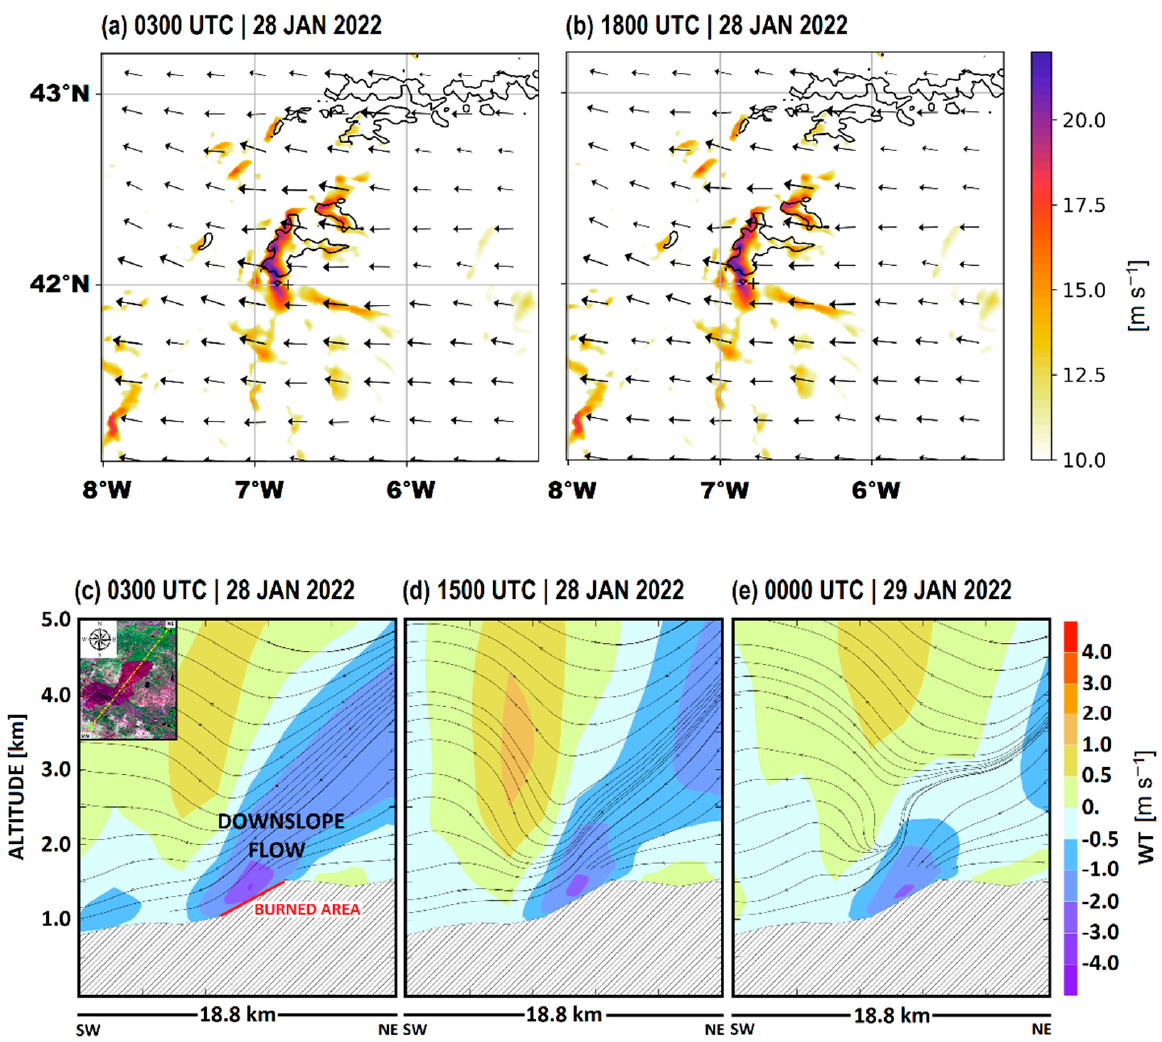
Figure 4. Regional to local atmospheric conditions were obtained from the numerical experiment with a 1500 m horizontal resolution: wind gusts at 10 m with arrows representing the horizontal wind vectors at 850 hPa level at ( a ) 0300 UTC and ( b ) 1800 UTC. The contour represents orography at 1500 m; SW–NE vertical cross-sections crossing the total burned area of vertical velocity and streamlines at ( c ) 0300 UTC, ( d ) 1500 UTC, and ( e ) 0000 UTC. The localization of the cross-section is indicated in the inner figure in ( c ). regions, with intense winds on the lee side, e.g., [15,47]. These orographic effects depend on mountain geometry, wind direction, and air stability, e.g., [49]. Near the surface, a high-pressure system centred over the Biscay Gulf induced the easterly flow over the northwest of the Iberian Peninsula. The orographic effects created by the complex terrain produced intense downslope winds where the fire occurred. Such an environment, with wind gusts above 15 m s − 1 , favoured fire propagation and, consequently, the burning of a large area on 28 January 2022. Therefore, intense wind gusts are found to play an important role in fire propagation over steep